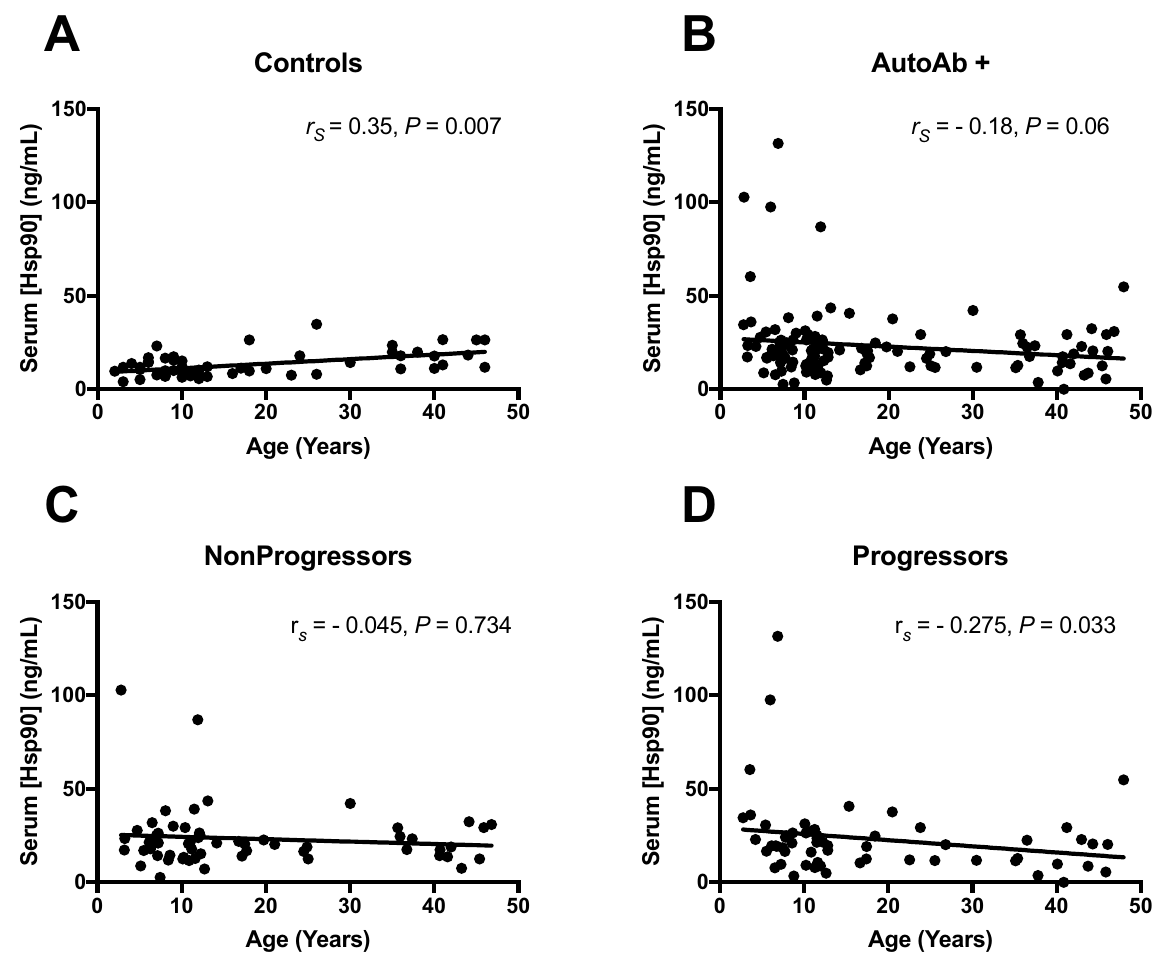
Fig 4. Correlations of serum Hsp90 levels with age. Spearman correlation coefficients were generated to test correlation of serum Hsp90 levels with age in n = 60 autoantibody-negative (A) and n = 120 autoantibody-positive (B) subjects and then separately for the nonprogressors (n = 60) (C) and progressors (n = 60) (D). A significant positive correlation between serum Hsp90 levels and age was observed in autoantibody- negative subjects ( r s = 0.35, P = 0.007), while serum Hsp90 levels exhibited a weak trend toward decreasing with age in autoantibody-positive subjects ( r = -0.18, P = 0.06). No significant relationship with age was observed in the nonprogressor group ( r s there was a significant negative inverse correlation with age in the progressors to type 1 diabetes ( r s = -0.275, P =